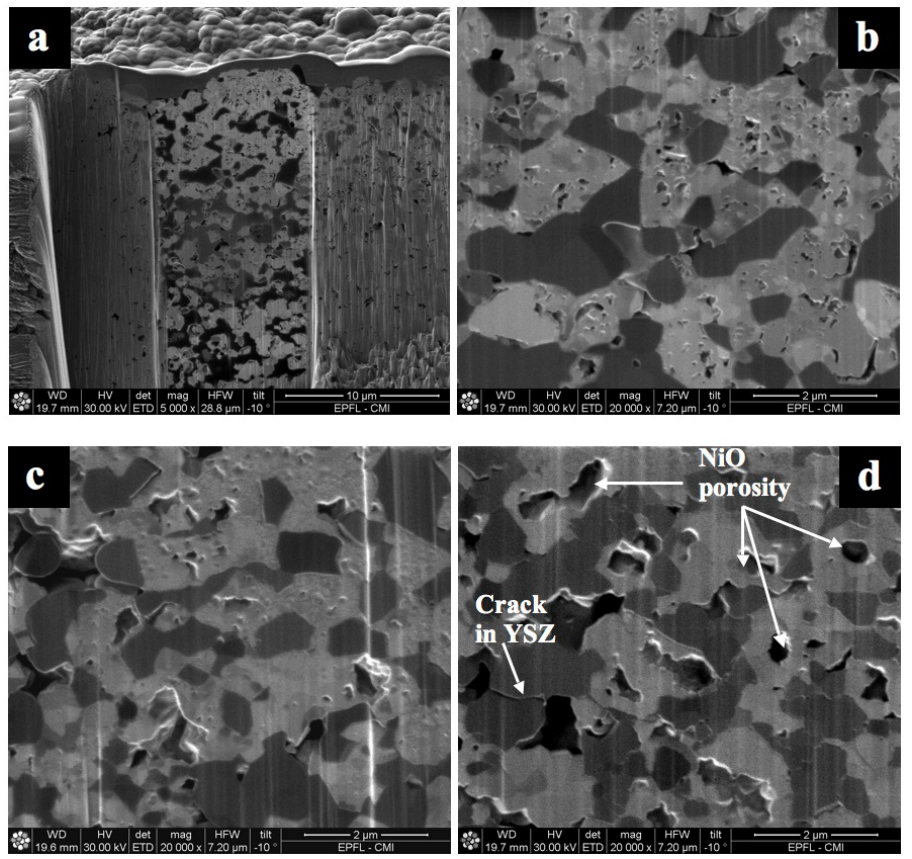
Figure 18. Secondary electron image from FIB cross-section from half-cells after one RedOx cycle ( a ) at 550 °C (lower magnification); ( b ) at 550 °C (higher magnification); ( c ) at 800 °C and ( d ) at 1000 °C. NiO contains small pores after a RedOx cycle at 550 and 800 °C but a single big pore after a RedOx cycle at 1000 °C. Dark grey is YSZ and light grey is NiO. The vertical lines come from the FIB milling process (“curtain effect”) [85].